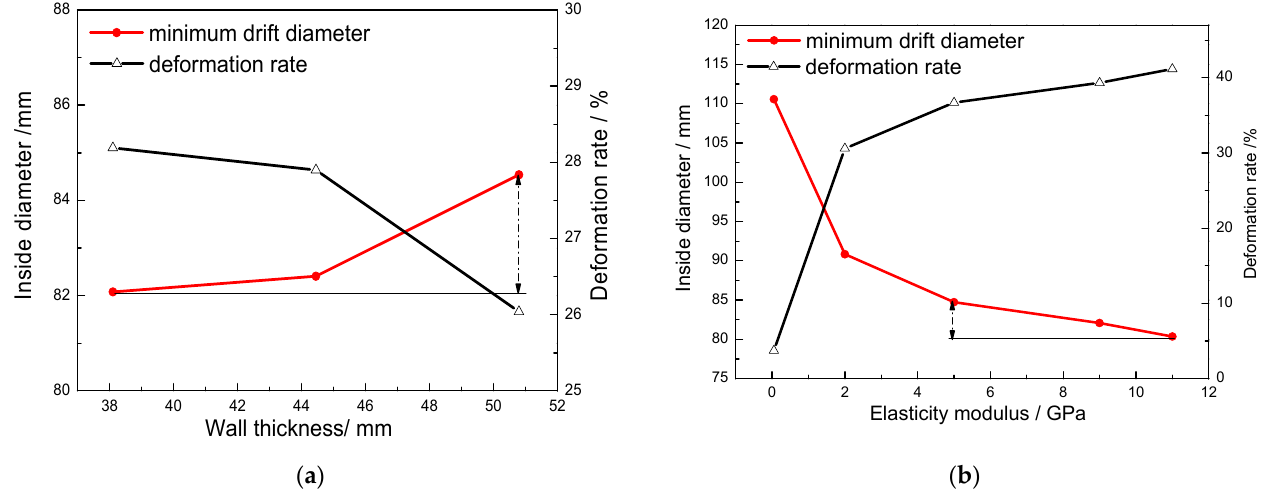
Figure 14. Effect of thickness and elastic modulus of cement slurry on casing inner diameter: ( a ) wall thickness; ( b ) elastic modulus.